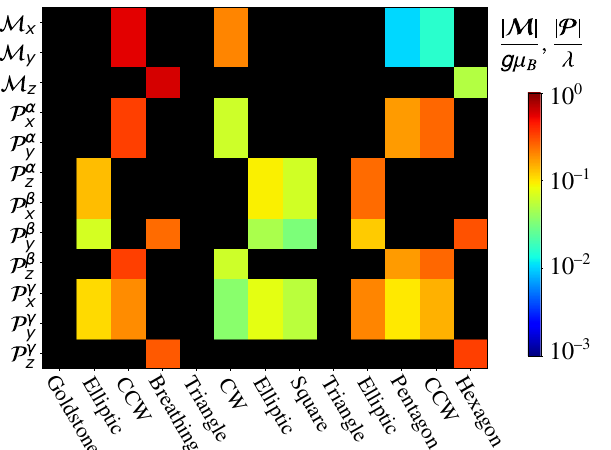
FIG. 3. Dynamical magnetic and electric dipole moments of low-energy magnon modes of skyrmion crystals in Cu 2 OSeO 3 . The dimensionless amplitudes of M /( g μ B ) and P /λ —plotted on a logarithmic scale—are obtained at D / J = 0.5 and g μ B B z J /( D 2 S ) = 0.8. We denote P α , P β , and P γ as electric